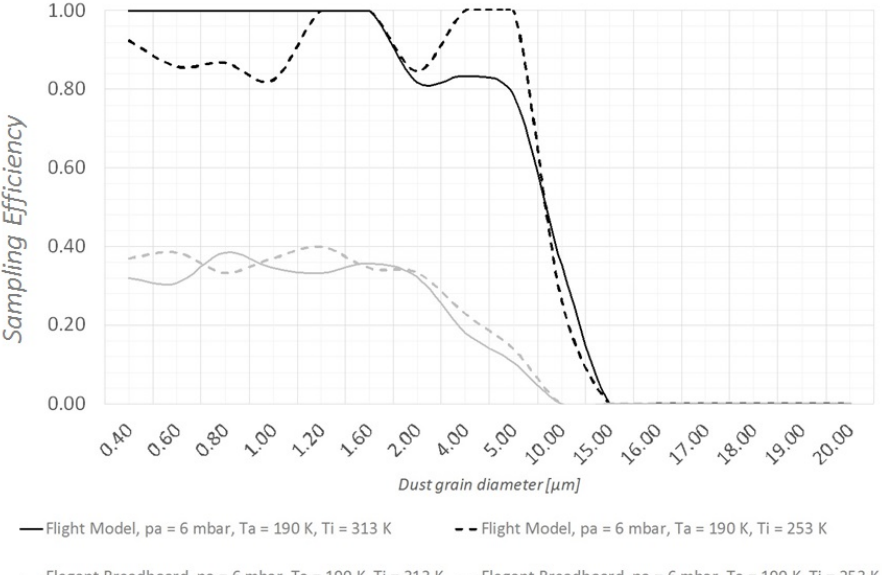
Figure 11. Comparison between Flight Model and Elegant Breadboard in terms of sampling efficiency, wind speed 2 m/s .